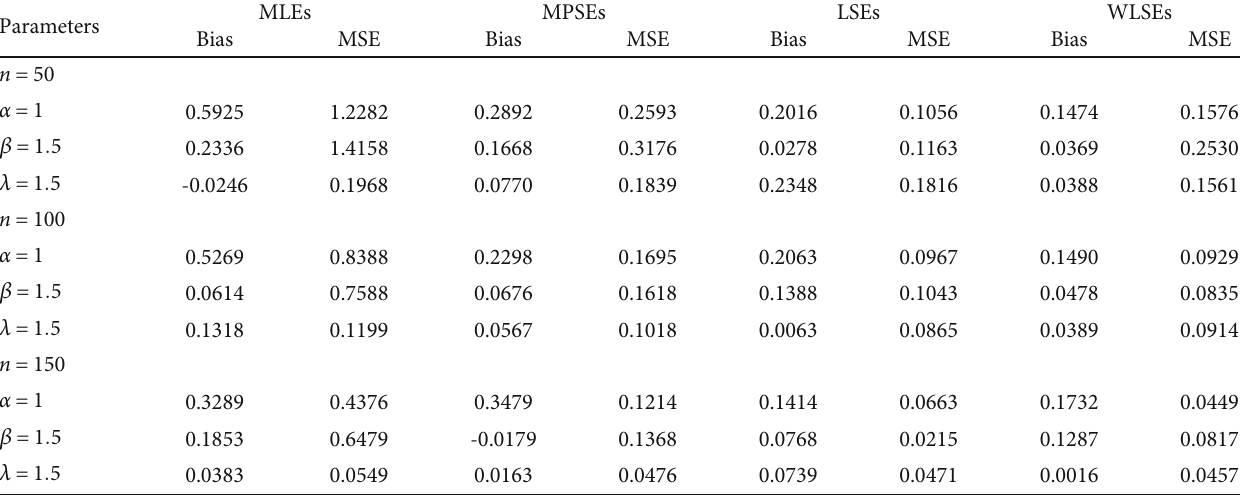
Table 4: Bias and MSE values for α , β , and λ of the XGAIW